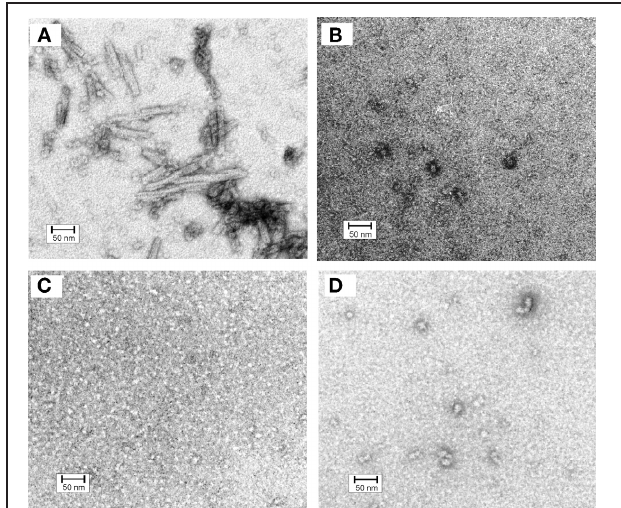
FIGURE 4 | Electron micrographs of cystatin C oligomers (A) HCC wt, (B) HCC V57D, (C) HCC V57N, and (D) HCC V57P. Oligomers were produced by incubation of protein samples at 3mg/ml concentration in 50mM AcONa (pH 4.0), 100mM NaCl, with continuous agitation at 48 ◦ C for 2h. Bar representing 50nm is shown as an indicator of the size. Protein samples were negatively stained with 2% (w/v) aqueous uranyl acetate for 30s and examined with a Philips CM10 electron microscope (Philips, Eindhoven, The Netherlands), operating at an excitation voltage of 100kV. The EM data were presented on a conference and were described but not reproduced in Szyma´nska et al. (2008). Here, the image (unpublished before) is given in order to enable better